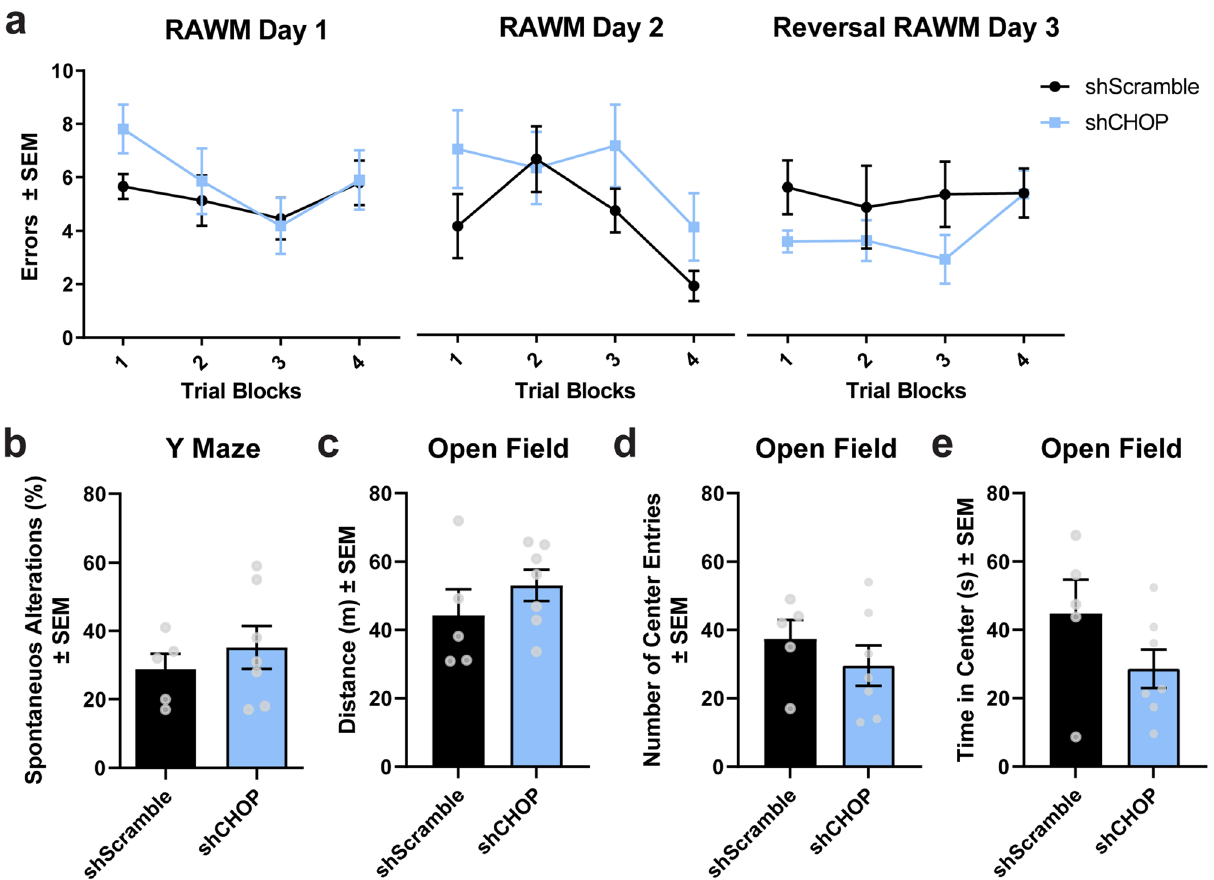
Figure 3. CHOP does not potentiate spatial memory deficits or anxiety-like behavior in rTg4510 mice. ( a ) Spatial memory was examined in using the radial arm water maze. ( b ) Y maze was used to assess working memory. ( c ) Locomotion (total distance travelled) and anxiety-like behavior by ( d ) number of entries and ( e ) time spent in the center area was measured using the open field test. A total of 12 rTg4510 mice [shScramble, n = 5; shCHOP, n = 7] were used for these tests. s = seconds; m = meters. Data is shown in standard error of the mean (± SEM) and analyzed by repeated measures one-way ANOVA (RAWM) or Student’s t-test (Y maze and open